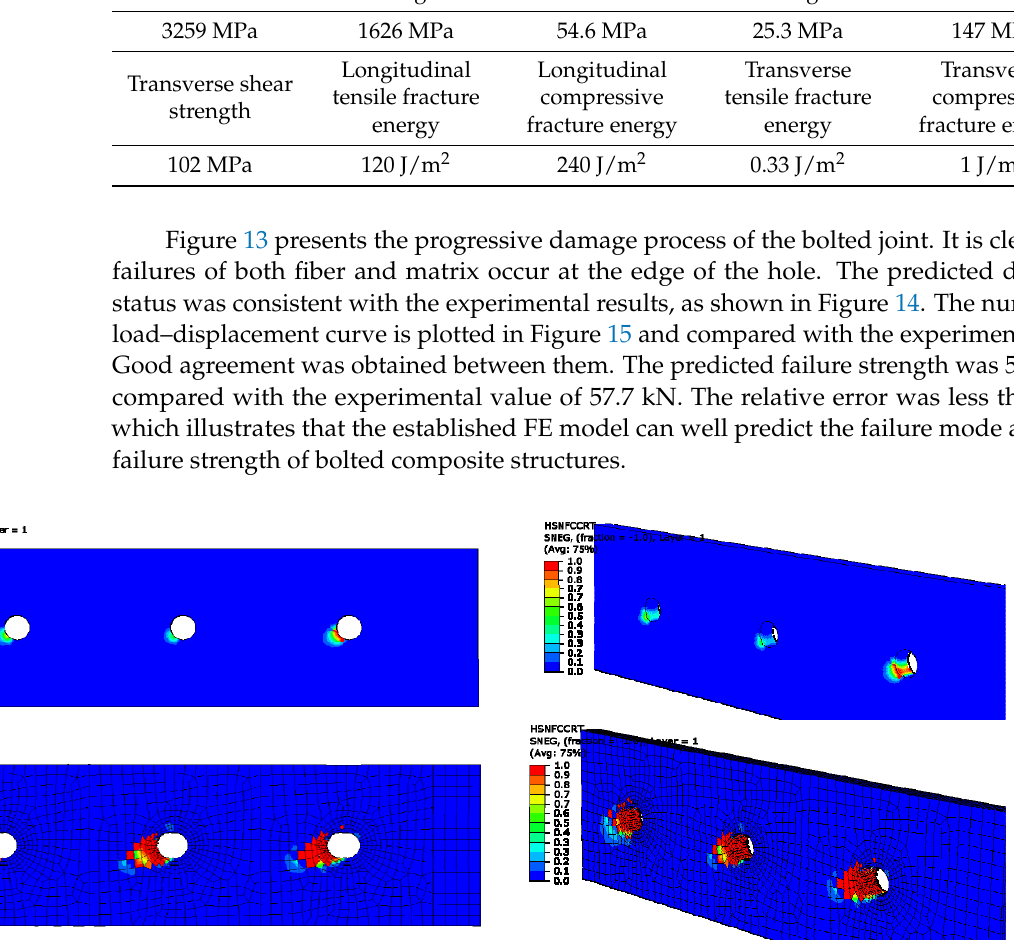
Table 6. Detailed values of the parameters used in the Hashin model.